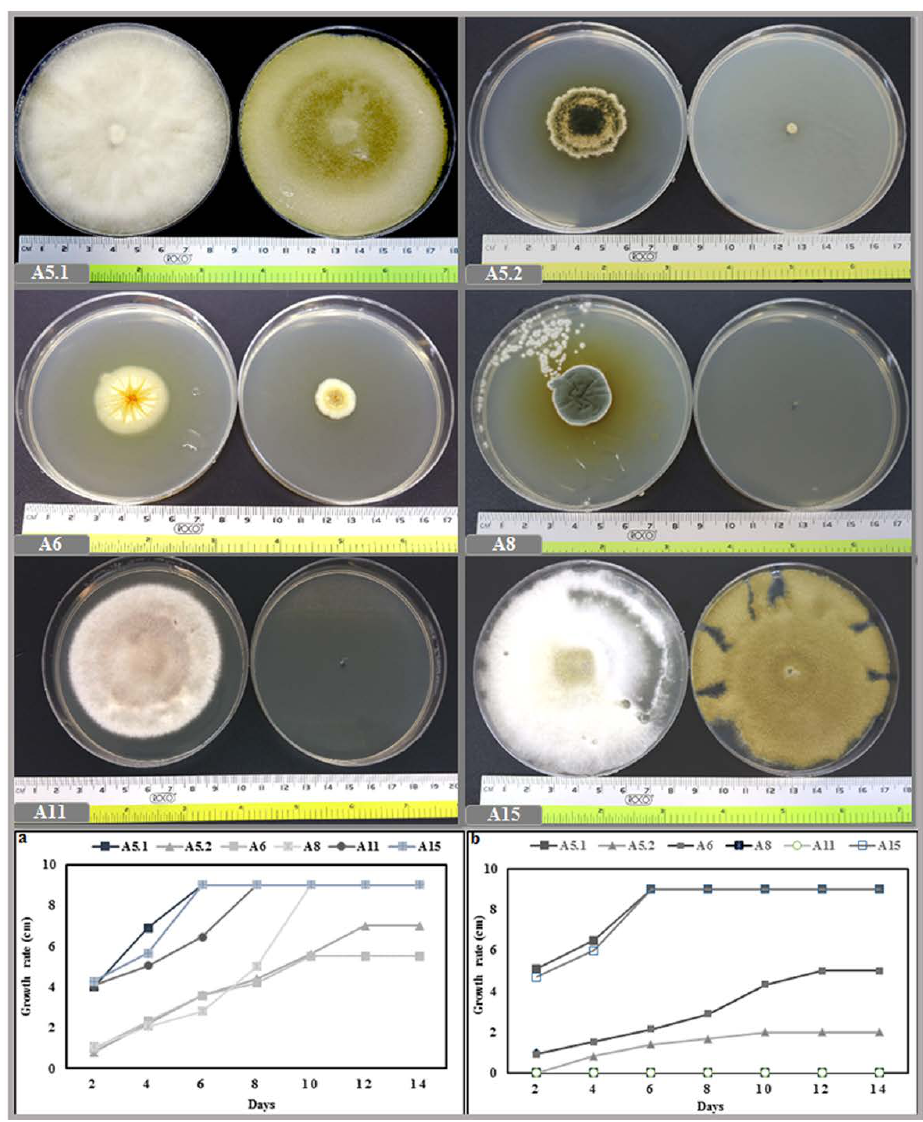
Figure 2. Effect of two incubation temperatures 27 ◦ C ( a ) and 40 ◦ C ( b ) on growth rate of the six isolated fungi. ( A5.1 : Byssochlamys spectabilis , A5.2 : Chaetomium globosum , A6 : Cephalotheca foveolata , A8 : Penicillium melinii , A11 : Alternaria tenuissima and A15 : Nigrospora chinensis